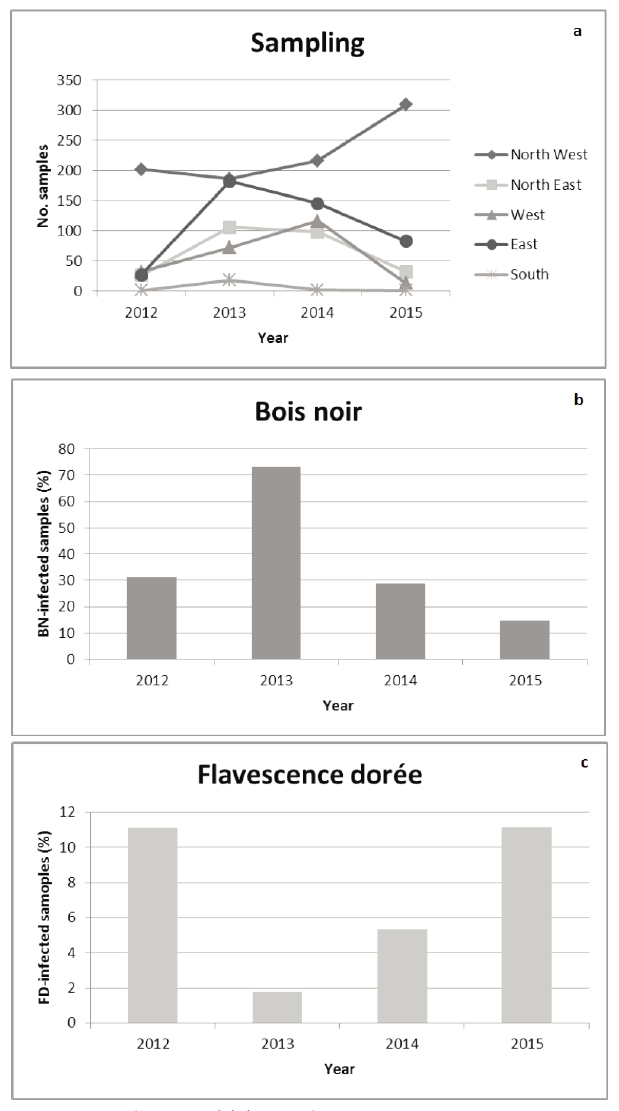
Fig. 3 - Distribution of (a) sampling among Tuscan provinces in 2012-2015. Samples infected by (b) “bois noir” and (c) “flavescence